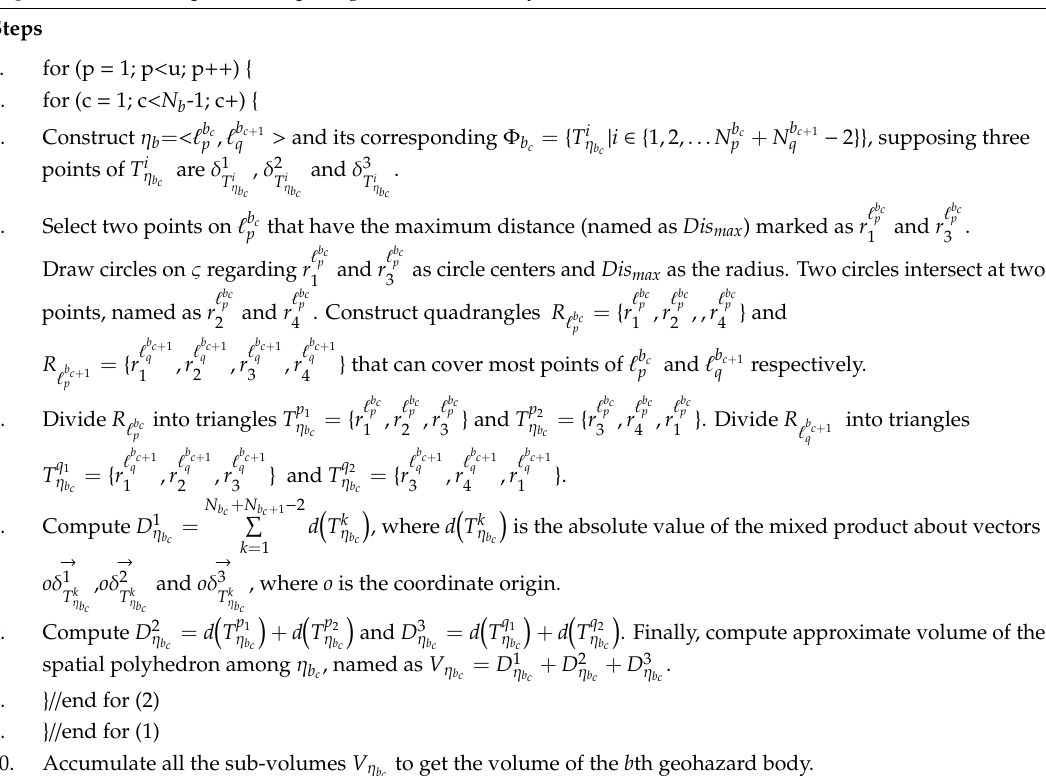
Algorithms 3 The Steps for Computing a Geohazard